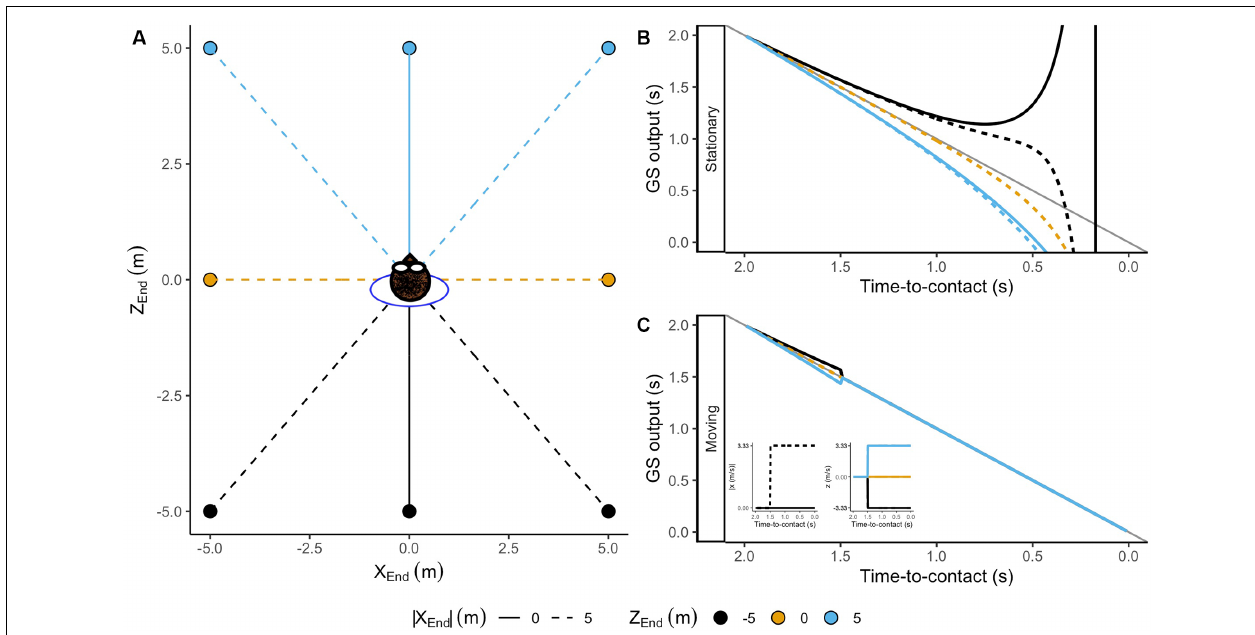
FIGURE 8 | (A) Ending positions for simulated trajectories around the observer. The lines represent the trajectories followed by the moving observer. Panels (B,C) depict the output of the GS model for a stationary and a moving observer. The line code indicates lateral ending position [ X End = 0, 5 (m)]. The color code indicates the ending position in depth [ Z End = − 5, 0, 5 (m)] . Note that the GS model predicts an underestimation of TTC for balls falling ahead and an overestimation of TTC for those falling behind the